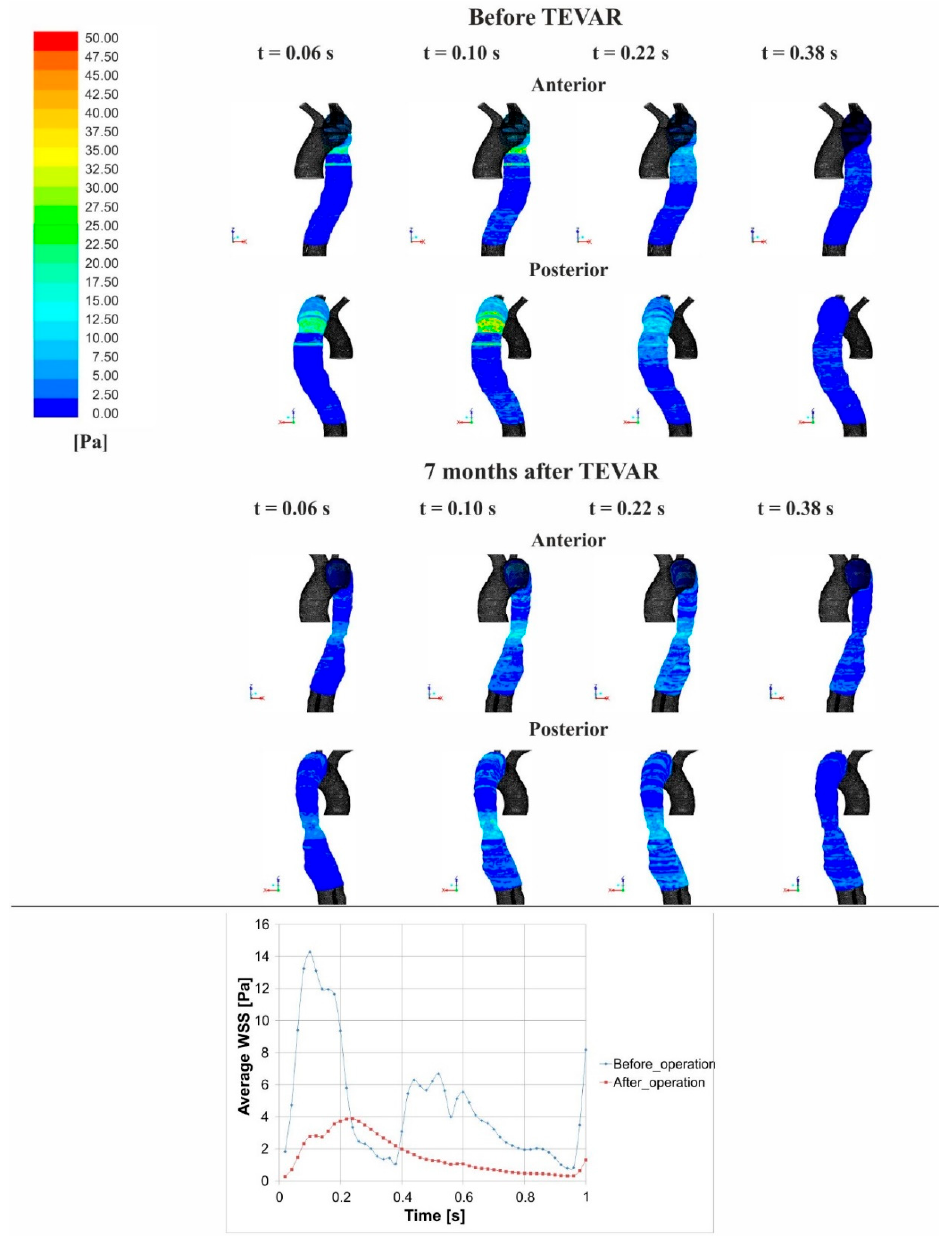
Figure 4. Changes in wall shear stress (WSS) contour distribution in the thoracic aorta for a representative patient. ( top ): WSS contour distribution in the thoracic aorta for representative time points before and 7 months after TEVAR; ( bottom ): the average velocity changes in the thoracic aorta for one cardiac cycle. Changes in WSS contours were presented for the anterior and posterior position in the left renal artery. Numerical were simulations calculated using ANSYS FLUENT software.